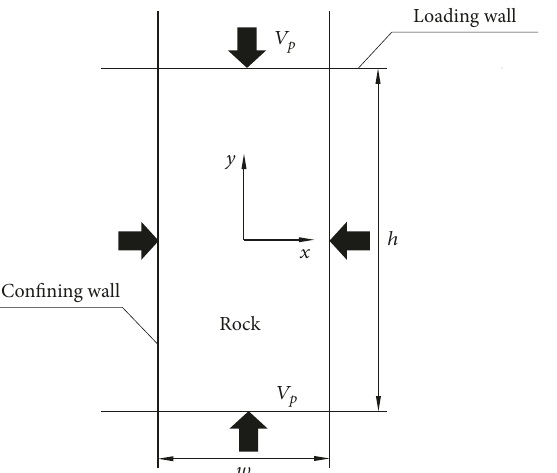
Figure 7: Relationships among uniaxial compression strength, peak strain, and loading